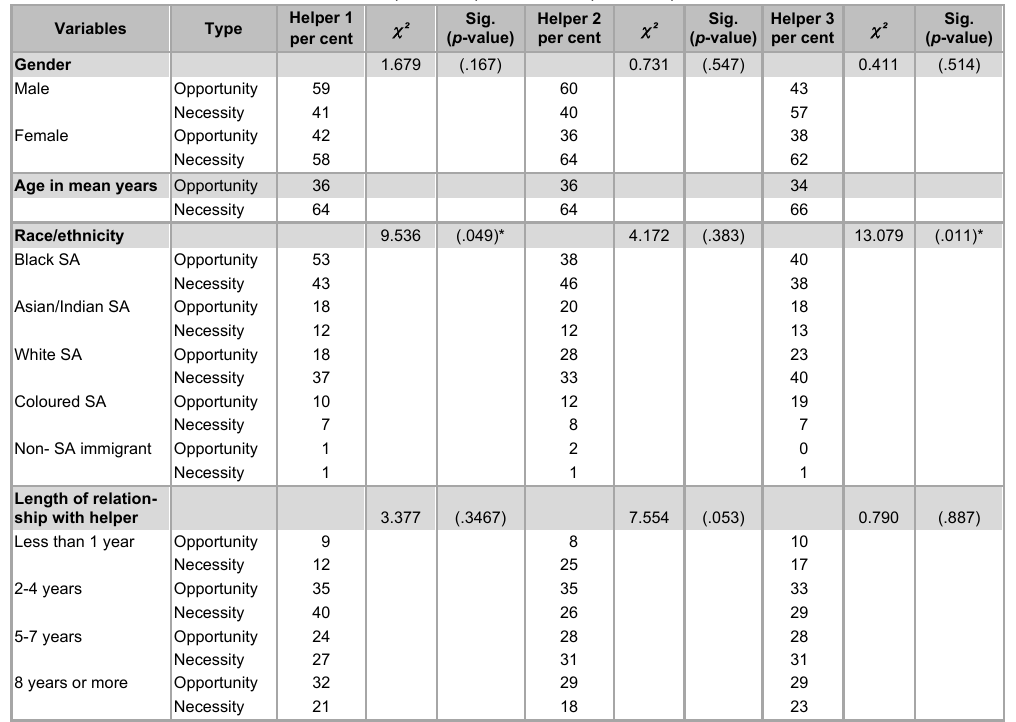
Differences in networking relationships, diversity and ties with helpers between NDE (n = 102) and ODE (n =